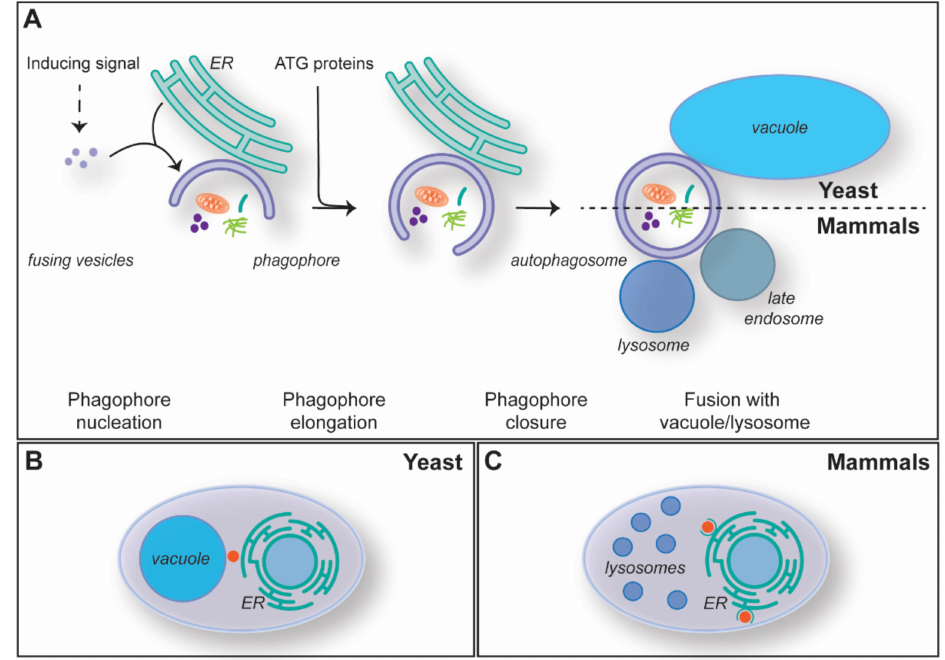
Figure 2. The mechanism of macroautophagy. ( A ) The mechanism of autophagosome formation and its key steps. ( B ) Subcellular distribution of the PAS (red dot) in the yeast Saccharomyces cerevisiae, which is localized in between the ER and the vacuole. ( C ) The sites of autophagosome formation (red dot) in mammalian cells are adjacent to the ER in specialized subdomains known as